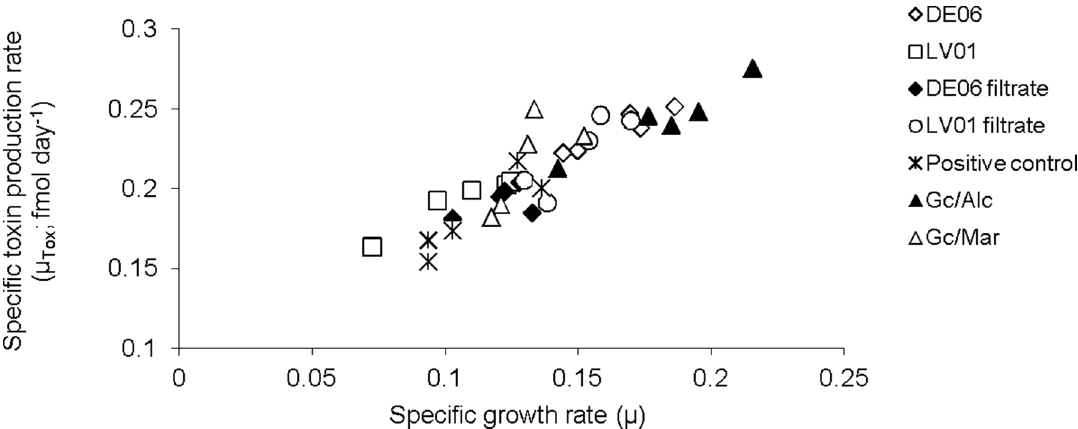
Figure 2. Relationship between specific growth rate ( m ) and specific toxin production rate ( m tox , fmol day 2 1 ). The relationship was established using 35 cultures of Gymnodinium catenatum measured between Day 0 and Day 25.